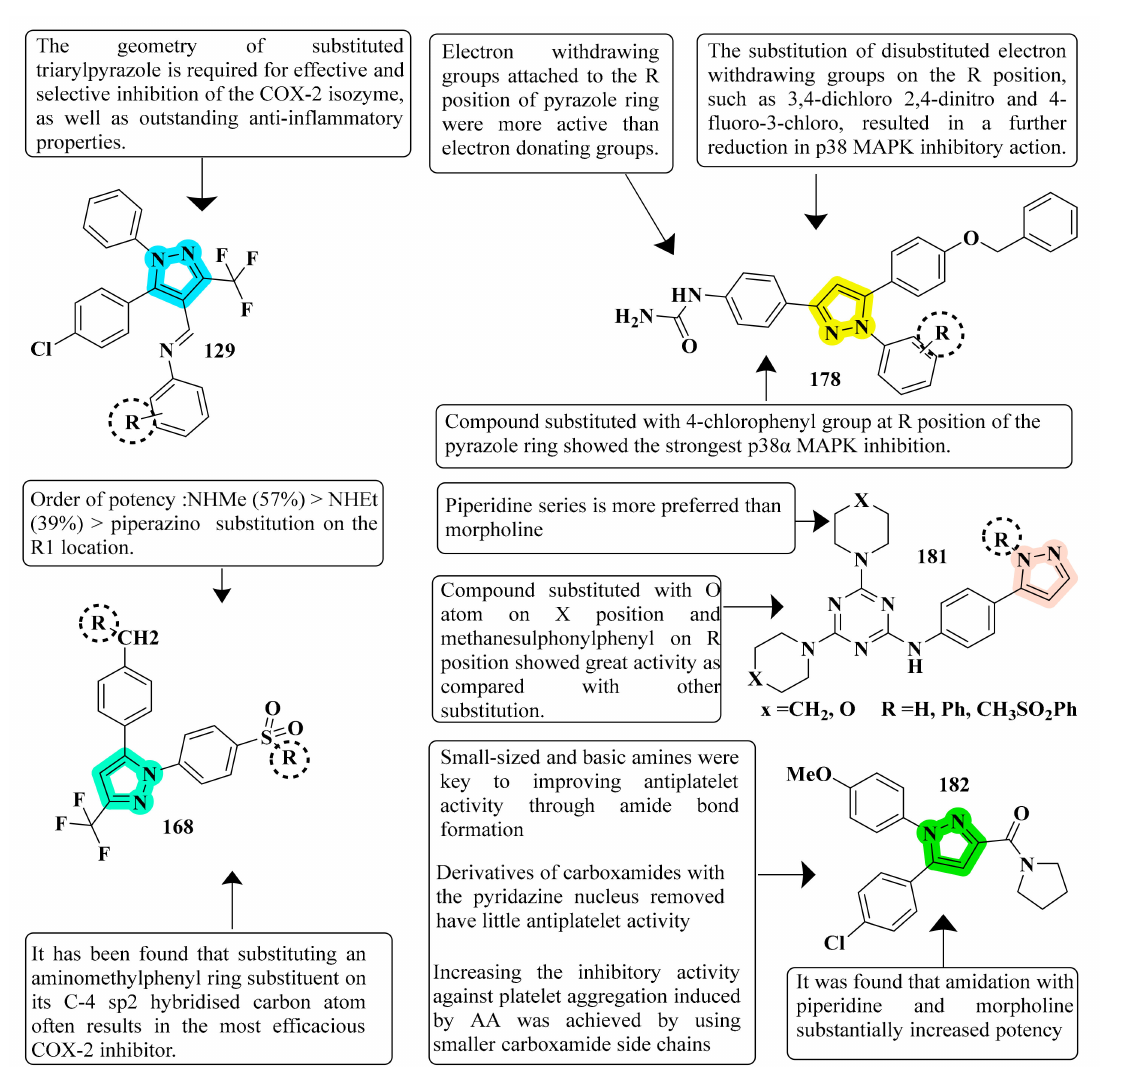
Figure 7. Structure and SAR of potent anti-inflammatory activity compounds 129 , 168 , 178 , 181 , and 182